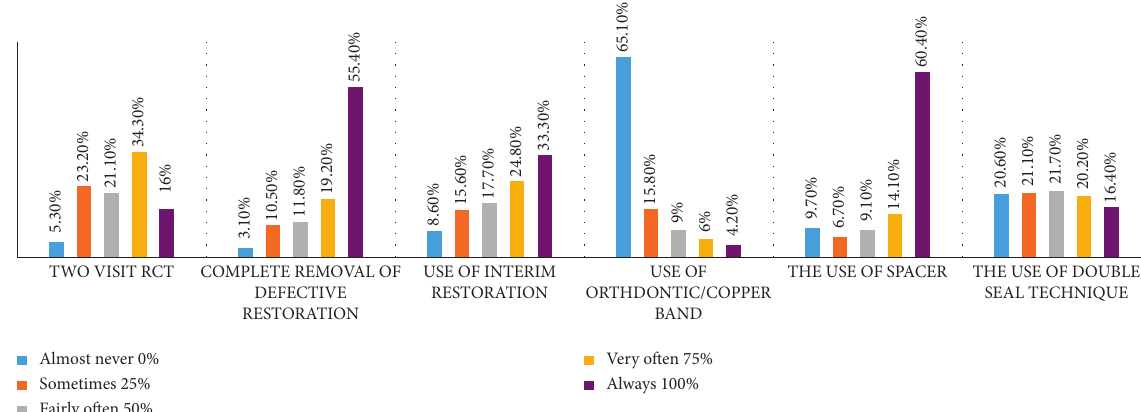
Figure 2: The frequency of two-visit RCT and the common practices of temporizing the root canal system in between the dental